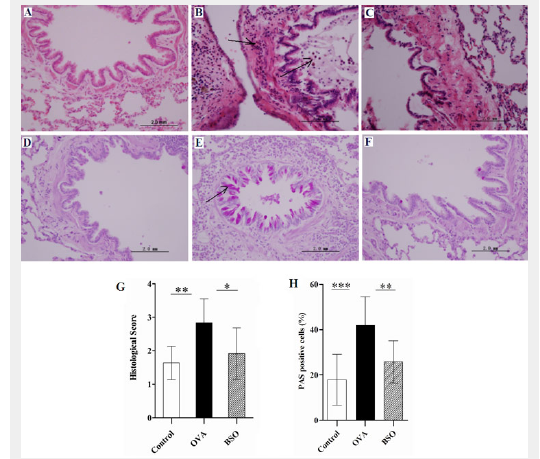
BSO suppressed the airway inflammation and goblet cell hyperplasia. Lung tissue was collected from three groups of rats for the determination of pathological changes. A and D represent lung sections of control rats which do not show pathological changes. B and E indicate lung sections of OVA challenged rats. (B) Infiltration of inflammatory cell around the airways and (E) goblet cells hyperplasia and mucous hyper secretion. C and F show sections from OVA challenged and BSO treated rats. BSO treatment inhibited the infiltration of inflammatory cells (C) and goblet cell hyperplasia and mucous hyper secretion (F) in the lungs. In representative histological images, lung tissues stained with HE (A, B, C; magnification 400X) or PAS (D, E, F; magnification 400X). The scoring data of pathological score (G) and percent of PAS positive cells (H). Arrow indicated the infiltration of inflammatory cells and goblet cells. Data shown as mean ± S.E.M. *P <0.05, **P <0.01 and *** P <0.001 compared between two